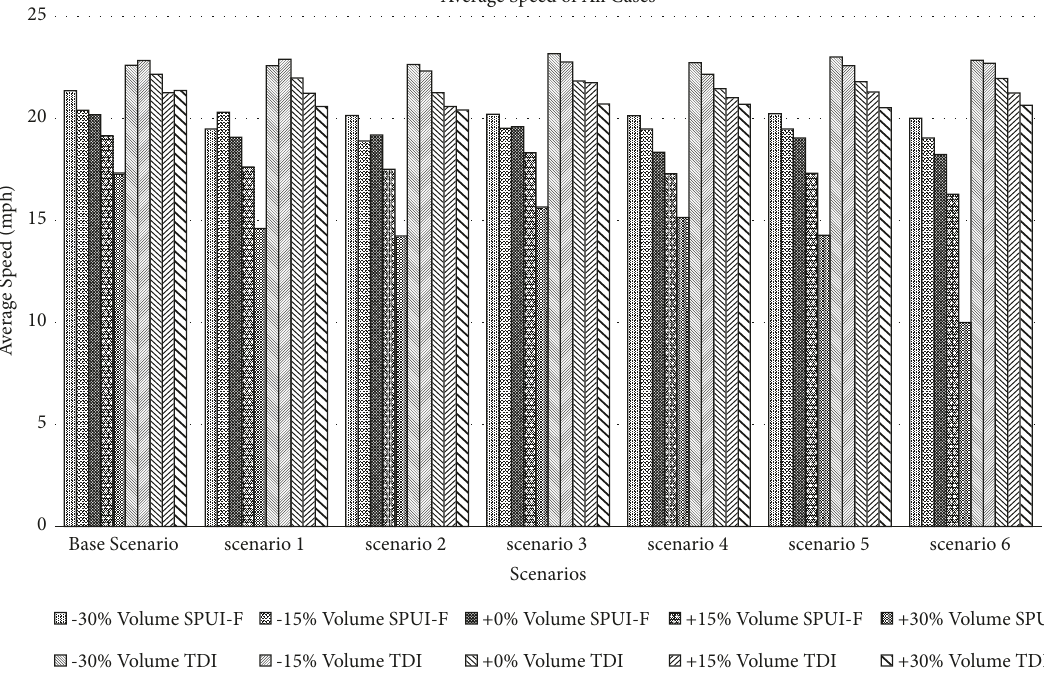
Figure 5: Comparison of average speed under various volume